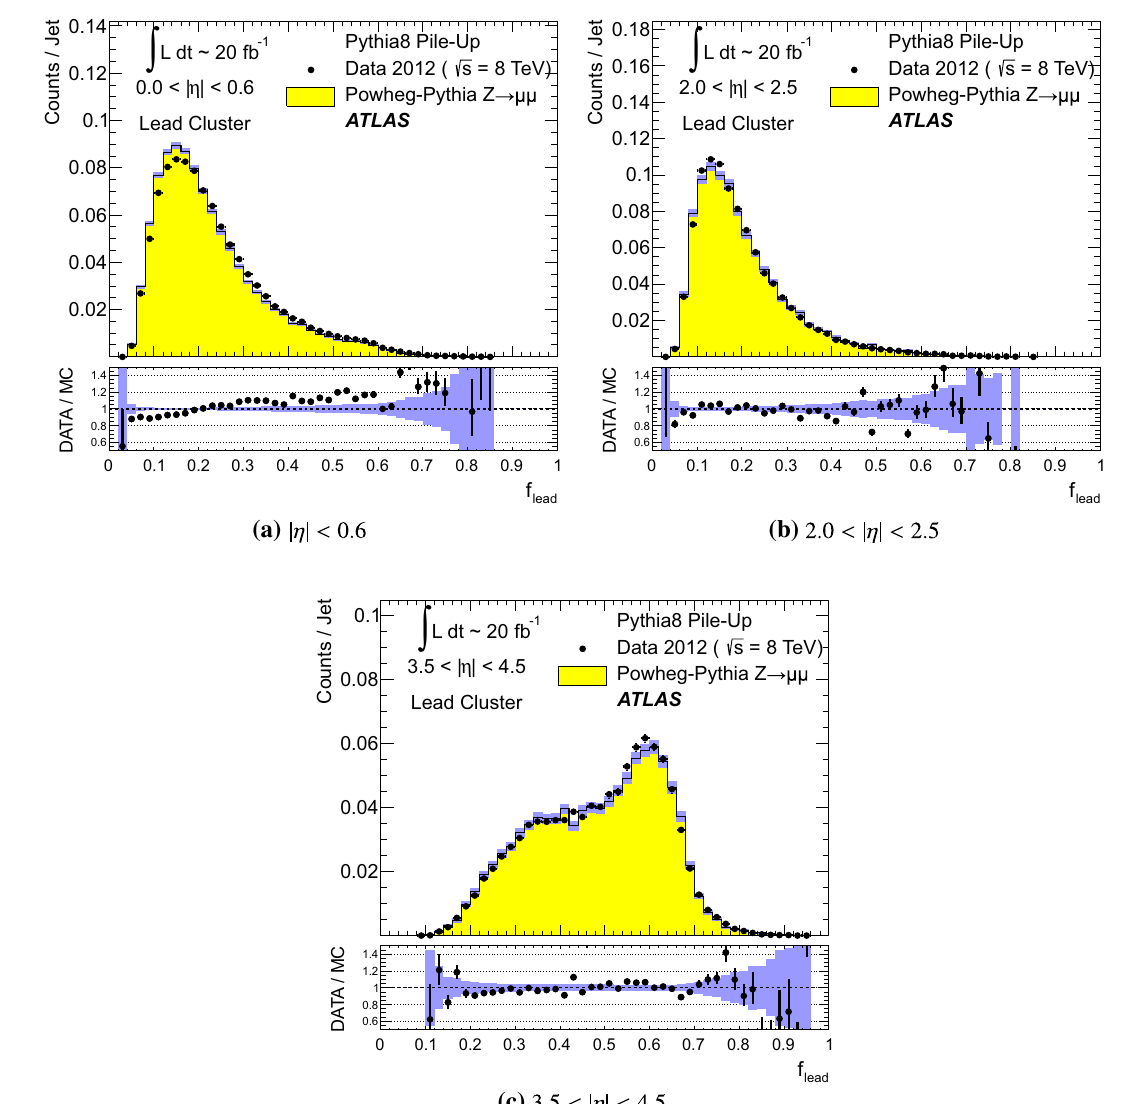
Fig. 39 The distribution of the signal fraction f lead carried by the MC simulations with fully simulated pile-up. The data-to-MC simula- leading topo-cluster in jets, as defined in Eq. (45), in a the cen- tion ratios are shown below the distributions. The shaded bands shown tral, b the end-cap, and c the forward detector region. The jets are for the distributions obtained from MC simulations indicate statistical reconstructed using the anti- k t algorithm with R = 0 . 4 and with uncertainties and the corresponding uncertainty bands in the ratio < 40GeV in Z → μμ events in 2012 data and 30GeV < p LCW + JES T , jet